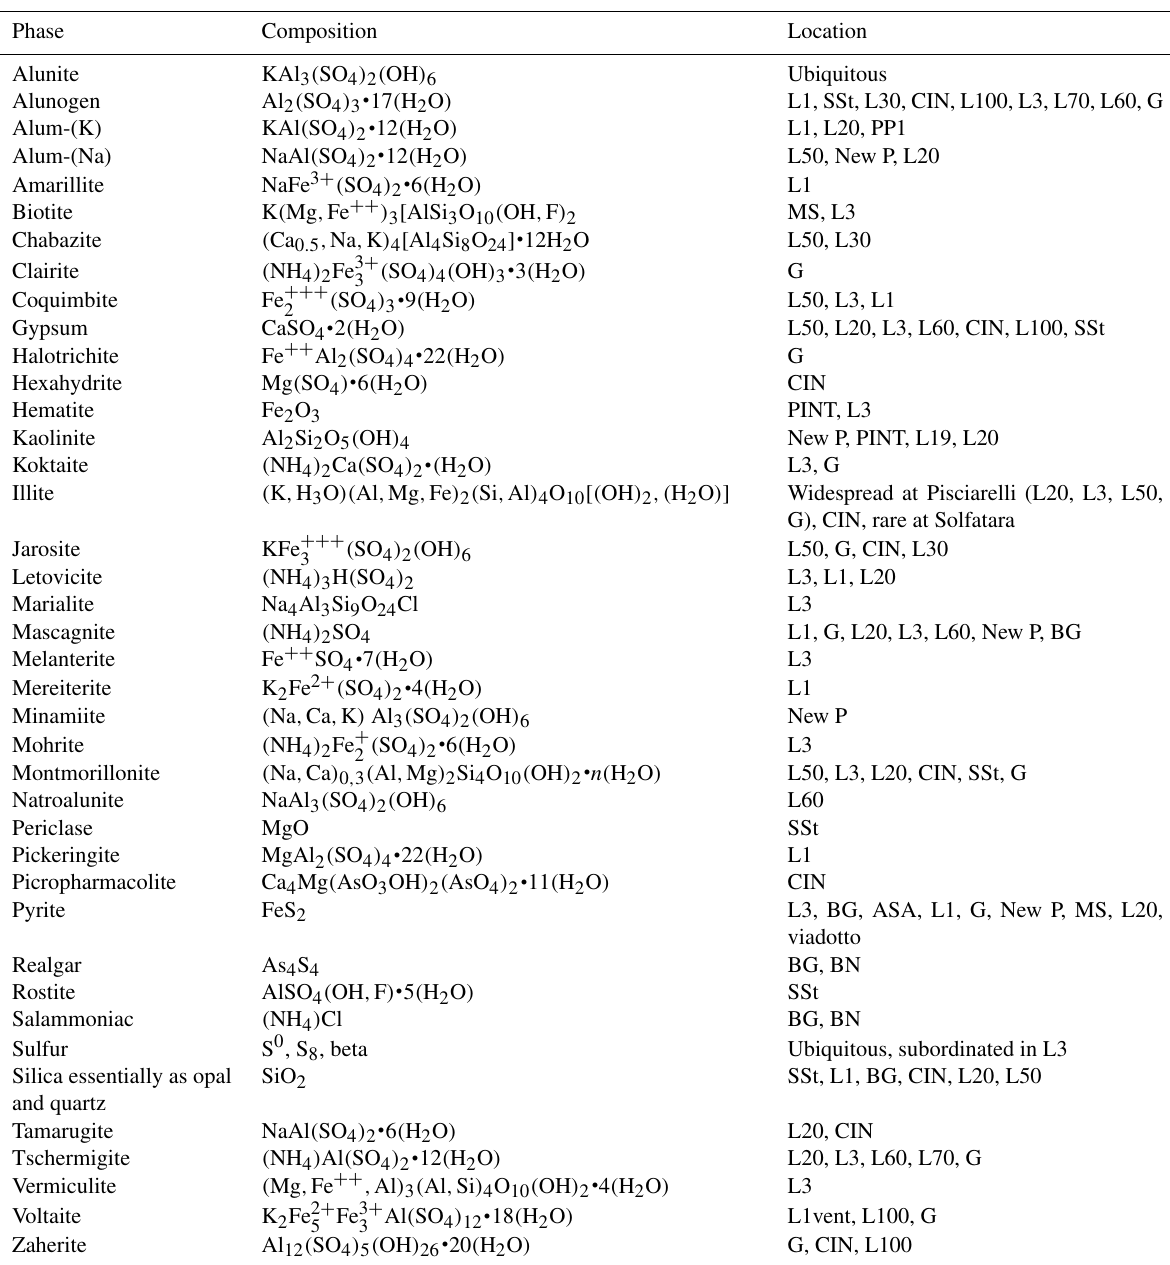
Table 1. Main hydrothermal minerals detected by XRPD with related ideal chemical formula and sites of occurrence (names as in Fig. 1a, d, e). The complete set of minerals is in Table S1. Refer to the Supplement for